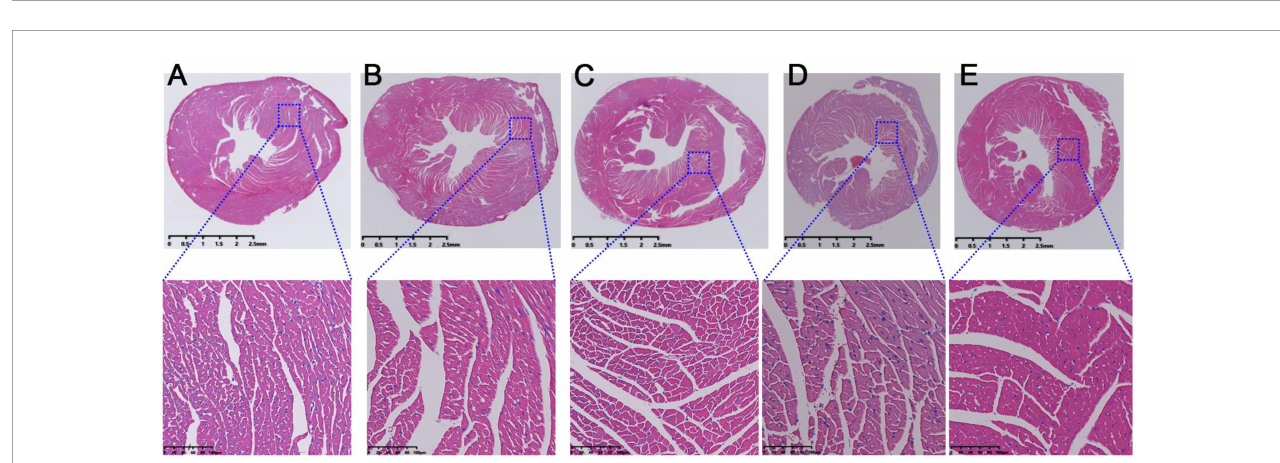
FIGURE3 The hematoxylin-eosin (HE) staining results of heart tissues in mice from control group (A) , model group (B) , rosuvastatin calcium tablets (RSV) group (C) , Allium macrostemon Bge. (AMB) group (D), and Allium chinense G. Don (ACGD) group (E)